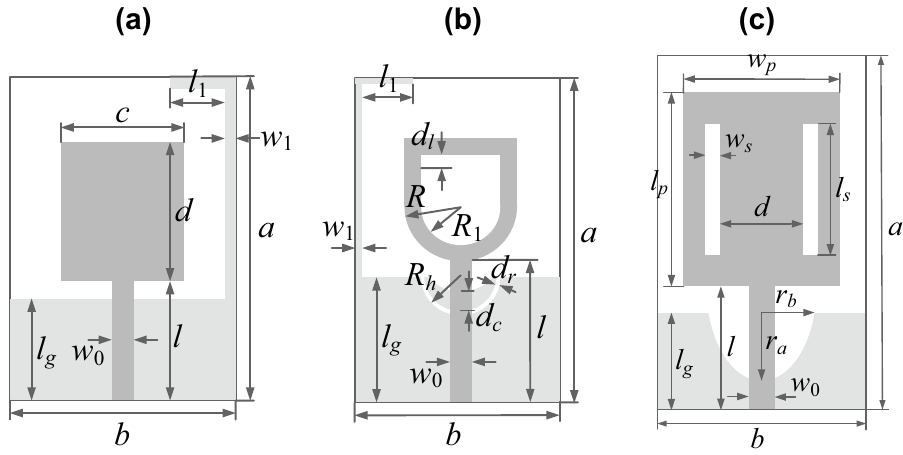
Figure 2. Benchmark antenna structures: (a) Antenna I 60 , (b) Antenna II 61 , (c) Antenna III 55 . Ground planes marked using light gray shade. (Microsoft Visio 2016, https:// www. micro soft. com/ pl- pl/ micro soft- 365/